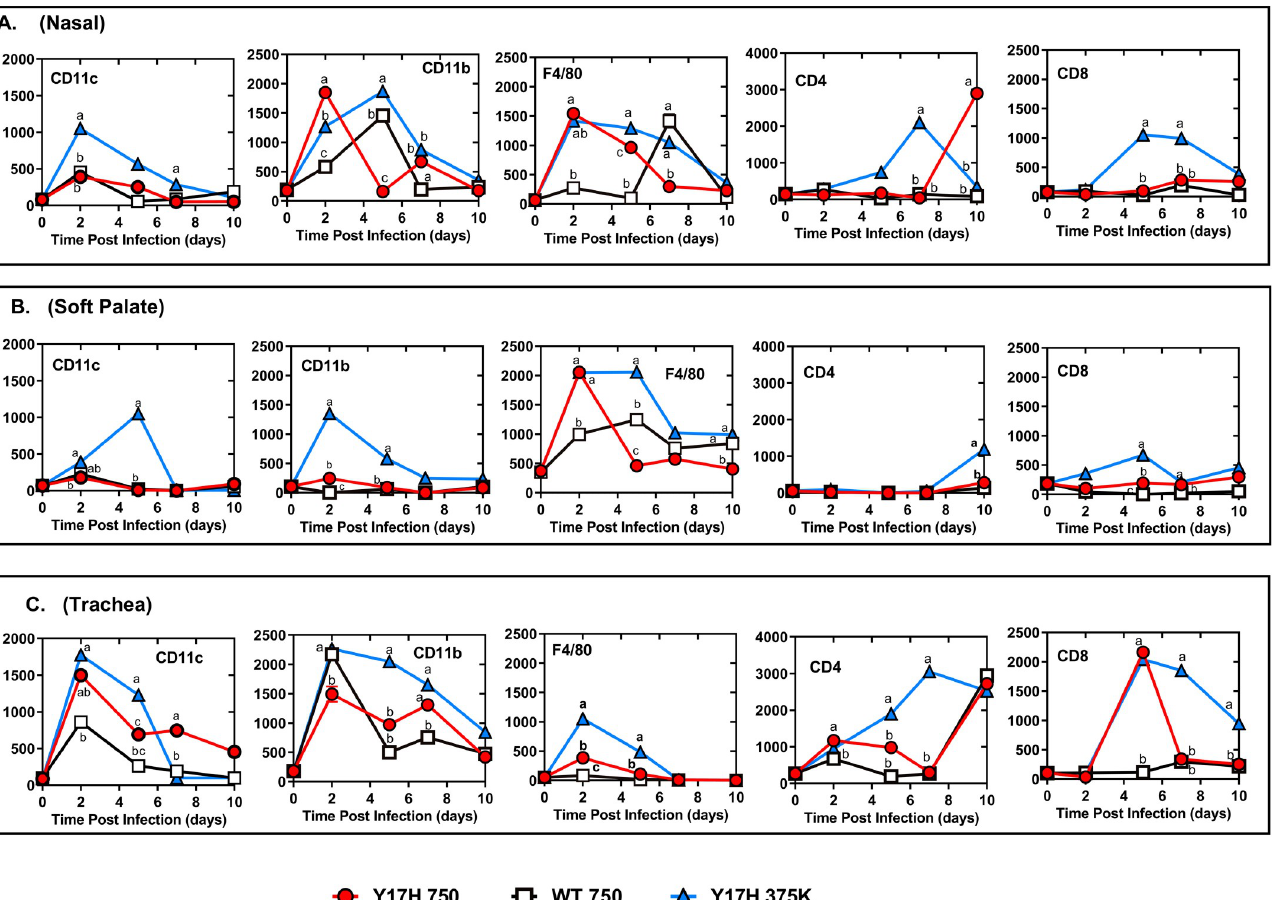
Fig 5. Local immune cell infiltration in the respiratory tracts of DBA/2 mice after infection. Mice were inoculated intranasally with PBS, WT virus (750 PFU), or Y17H virus (750 or 375,000 PFU). ( A-C ) Values of the mean florescence intensity of positive immune cell populations in response to viral infection in nasal tissues (A), soft palate (B), and trachea (C). The local immune cells were stained with antibodies raised against CD11c, CD11b, F4/80, CD4, and CD8 for each tissue, as labeled in the top left corner of each panel. After 2, 5, 7, or 10 days of infection, single epithelial cells from a homogenate of three mice per group were isolated, and the number of CD11c + , CD11b + , F4/80 + , CD4 + , and CD8 + cells were determined by flow cytometric staining and analyses. The displayed values are the mean ( ± SD) of two independent experiments, with each experiment including a homogenate of three replicates. Statistical analysis was performed by using two-way ANOVA and Tukey posthoc tests. At each time point, means are denoted by a different lower-case letter that indicate significant statistical differences between groups ( P = 0.001), whereas means with the same letters indicate no significant statistical